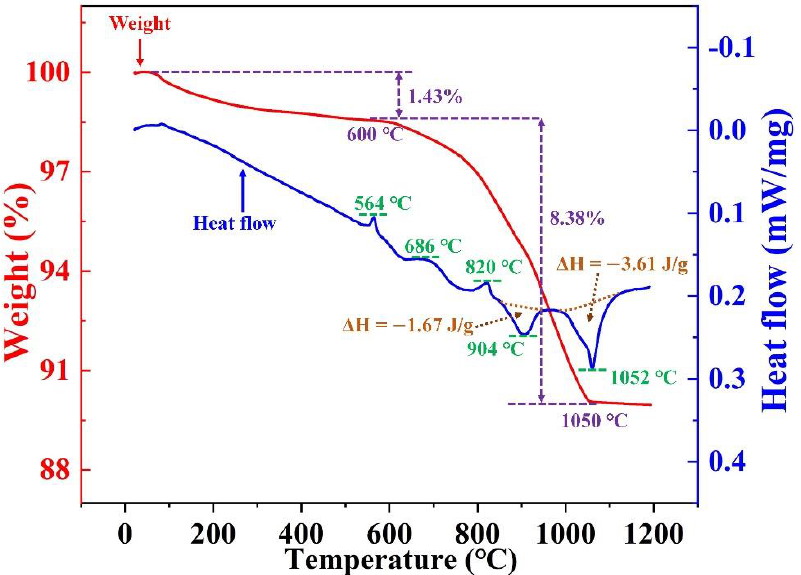
Figure 10. TG-DSC curves of SAD – Na 2 CO 3 mixtures for the n(N/A) of